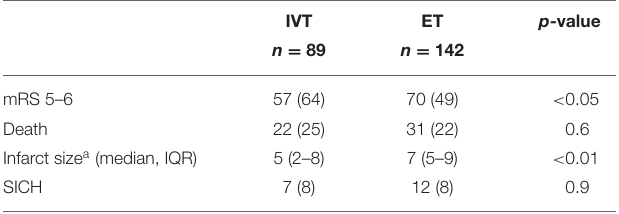
TABLE 3 | Clinical and imaging outcomes after intravenous thrombolysis (IVT) or endovascular treatment (ET) in previously dependent patients at the time of discharge.